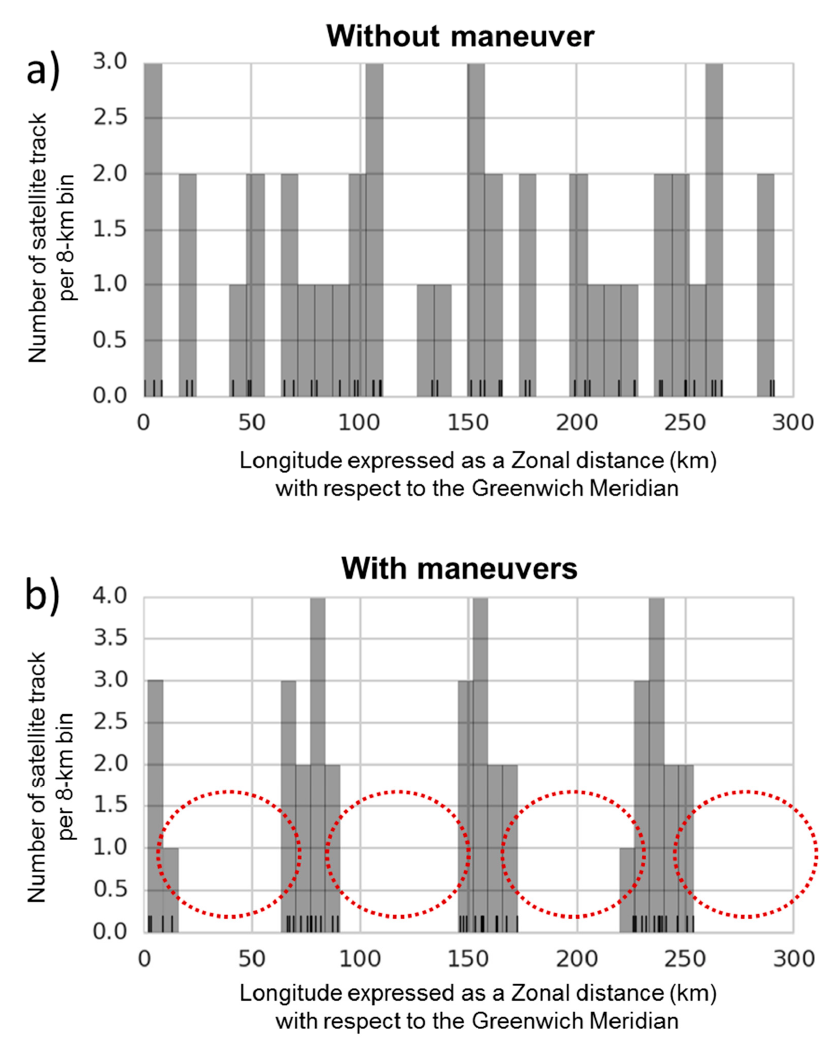
Figure 6. Simulated zonal distance (in km) of the equator crossing of ascending tracks after one year of AltiKa drifting phase (DP) (black ticks) over a 2.7° longitude region. The grey histogram shows the number of altimeter tracks in 8-km bins. Panel ( a ) is a simulation where the satellite altitude is not maintained: the distribution of altimeter tracks is relatively random with 0 to 3 tracks in each 8-km bin). Panel ( b ) is a simulation where the orbit altitude decay is mitigated with one maneuver in the middle of the drifting phase: this maneuver single-handedly aggregates all altimeter tracks in 30-km bands (typically 2 to 4 tracks per 8-km bin), leaving all the other regions completely unobserved (red circles). In other words, this prediction shows that one year of SARAL DP does not yield a perfect 8-km geodetic grid since some grey bins are empty and other bins have up to 3 satellite track samples. But on average, all regions are reasonably well covered, albeit with a somewhat random and irregular pattern. This kind of random distribution was predicted for all regions and all solar flux scenarios.